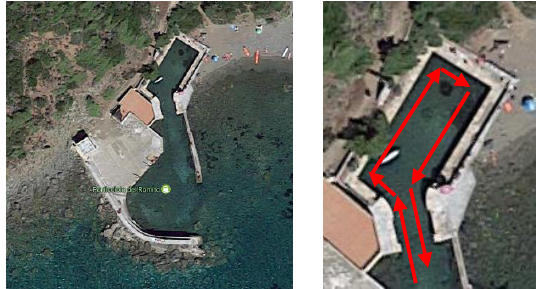
Figure 8. An aerial view of the port structure (left) and an enlarged sight of the rectangular basin chosen for the tests with a schematic view of the photogrammetric strip acquired (right).